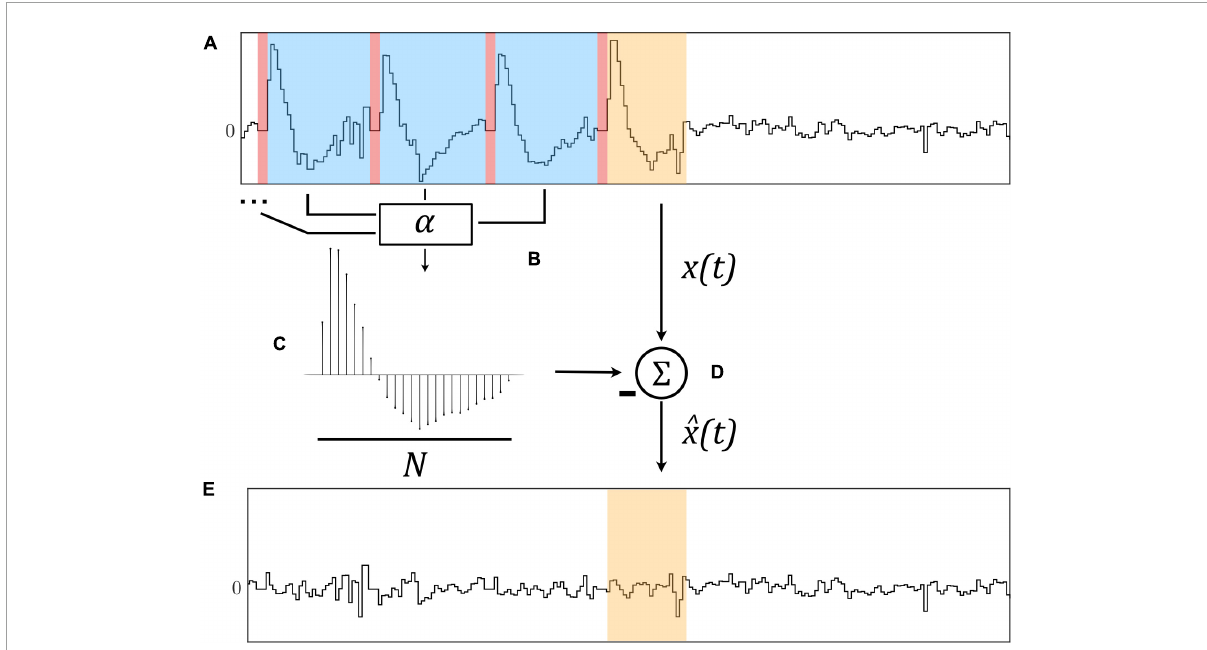
FIGURE1 The Template Subtraction (TS) algorithm identifies stimulation artifacts from the original signal x ( t ) [ (A) , in blue] immediately following neurostimulation [ (A) , in red] and averages them using exponential filters (B) to form an artifact template (C) . This template is subtracted from a newly-identified artifact [ (D) , in orange)] to yield an estimated artifact-free signal (cid:98) x ( t ) (E) .